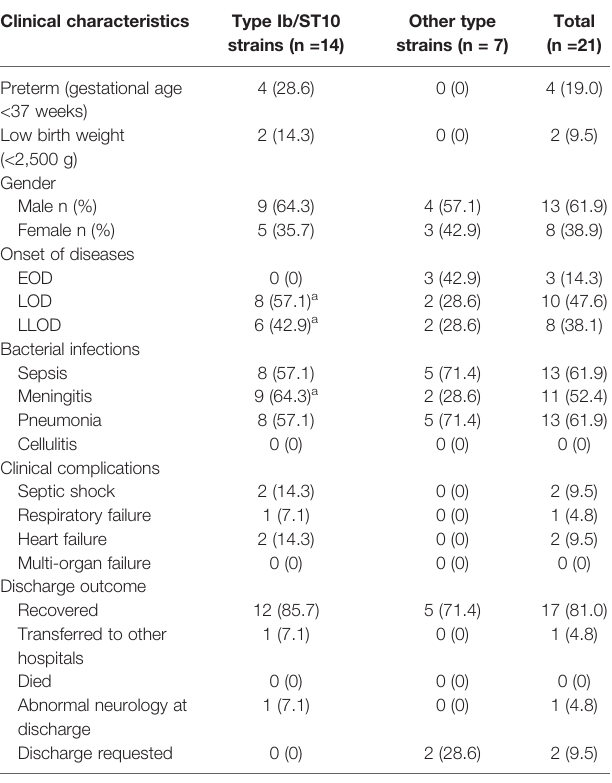
TABLE 3 | Demographics and clinical features of infants with type Ib/ST10 GBS invasive infections compared with those with other GBS invasive infections. Clinical